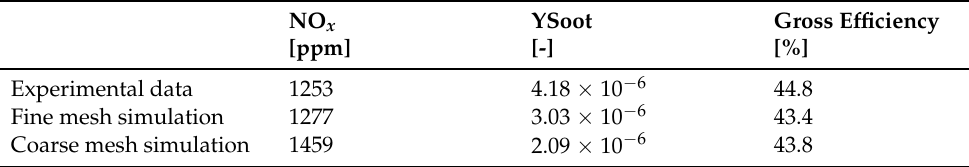
Table 4. Comparison between the experimental and CFD simulation values. NO x YSoot Gross Efficiency [ppm] [-] [%] Experimental data 1253 4.18 × 10 − 6 44.8 Fine mesh simulation 1277 Coarse mesh